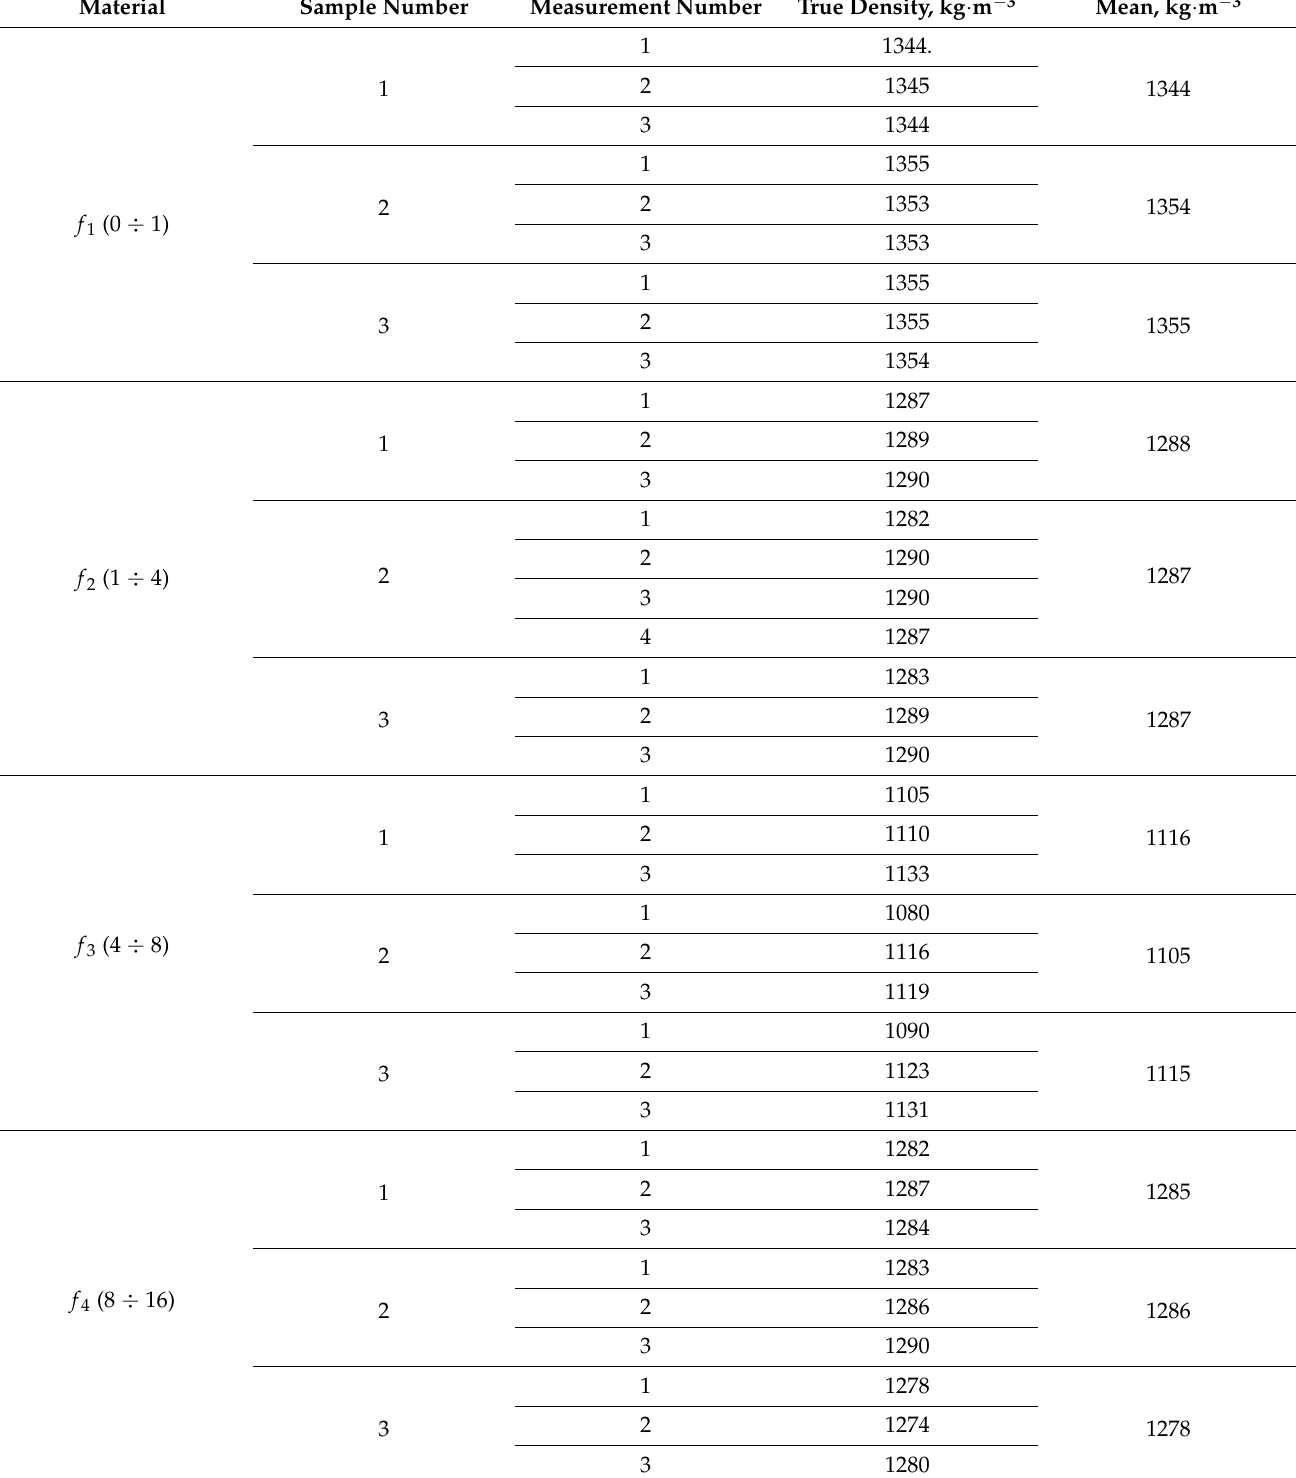
Table 3. The shredded forest residues true density tests